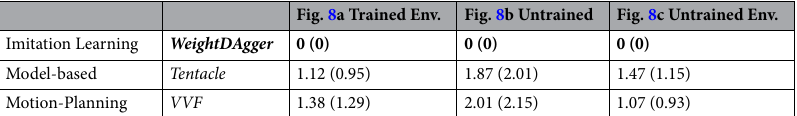
Fig. 8a Trained Env. Fig. 8b Untrained Fig. 8c Untrained